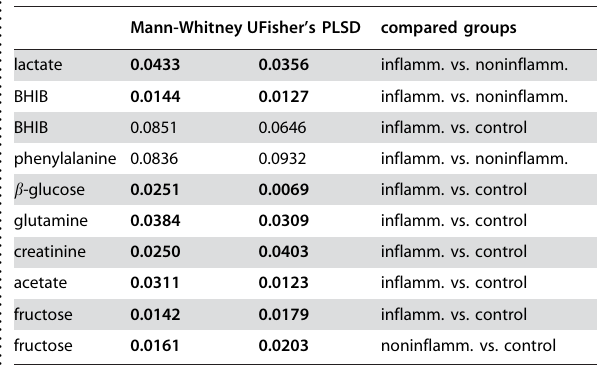
Table 3. Significance of differences in CSF metabolites between CIS patients with and without inflammatory MS